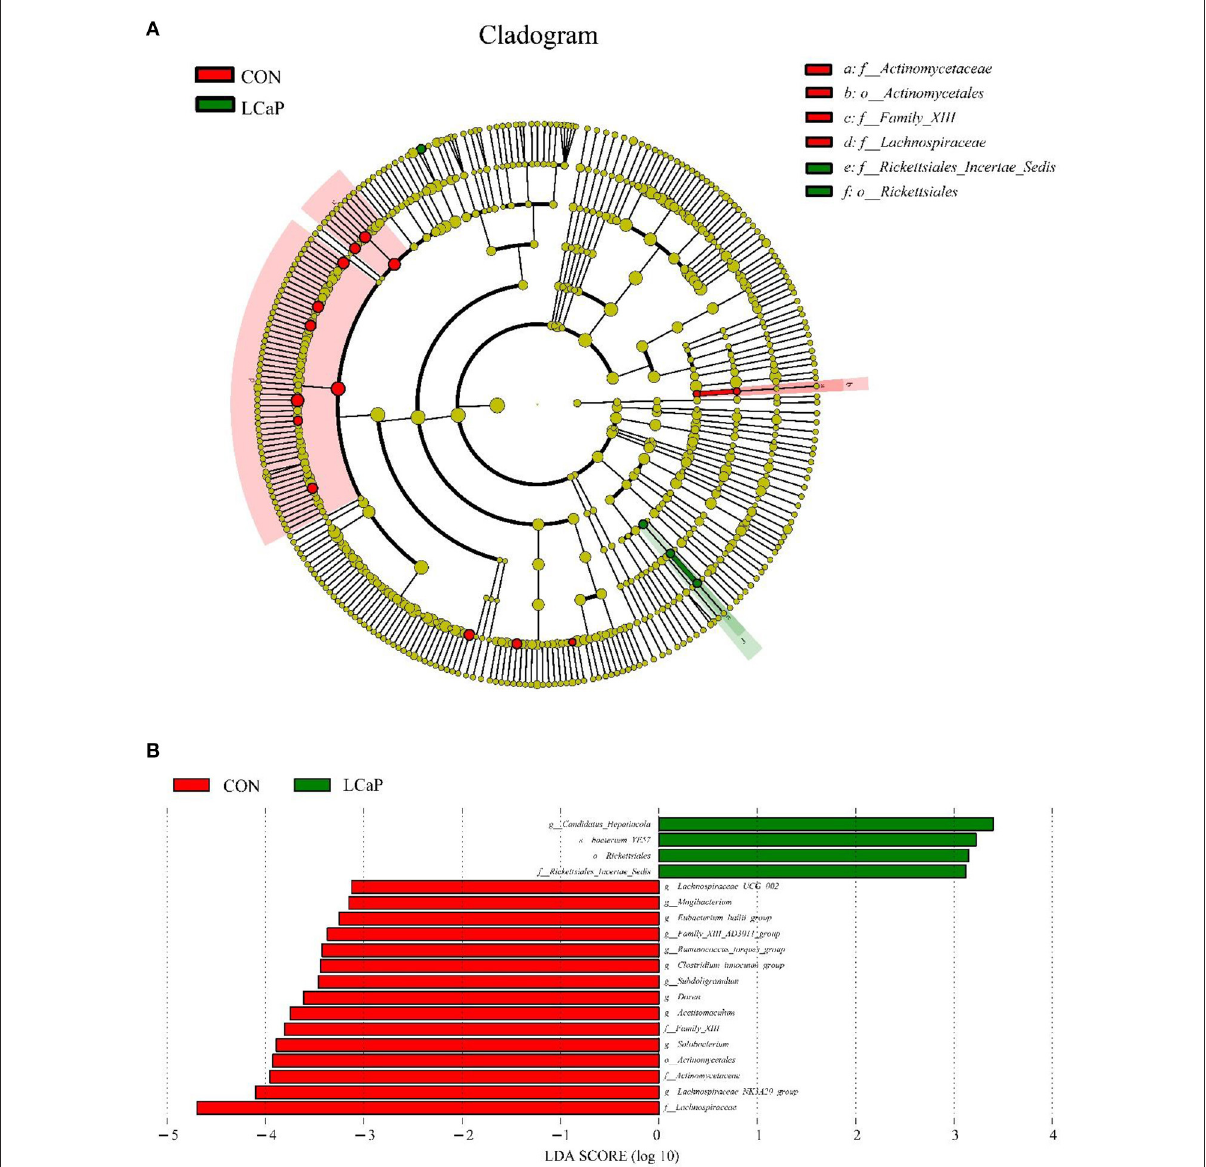
FIGURE4 Linear discriminant analysis effect size (LEfSe) analysis of significant differences in fecal bacterial community composition between the CON and LCaP groups. (A) LEfSe analysis-derived taxonomic cladogram. (B) Linear discriminant analysis (LDA) scores. Significant differences were defined as LDA scores > 3 and P < 0.05. CON, control group; LCaP, low calcium propionate group, basal diet + 200 g/d calcium